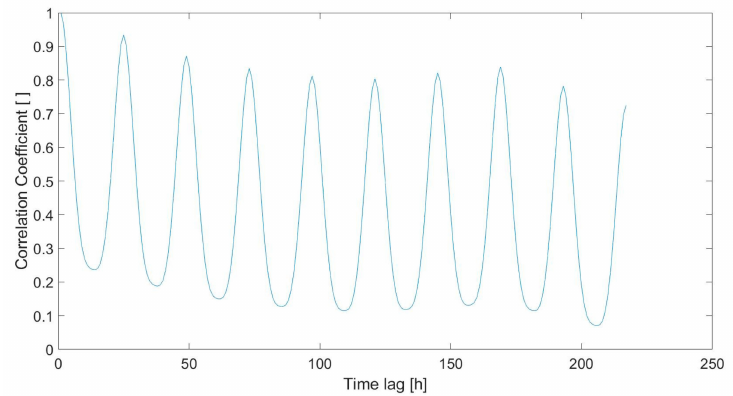
Figure 8. Correlation coefficient curve for evaluating short-term periodicity characteristics of the Greek system load curve for the full year 2021. Strong correlation exists with the 24 h lagged load (previous day) and, to a lower extent, with the 168 h lagged load (previous